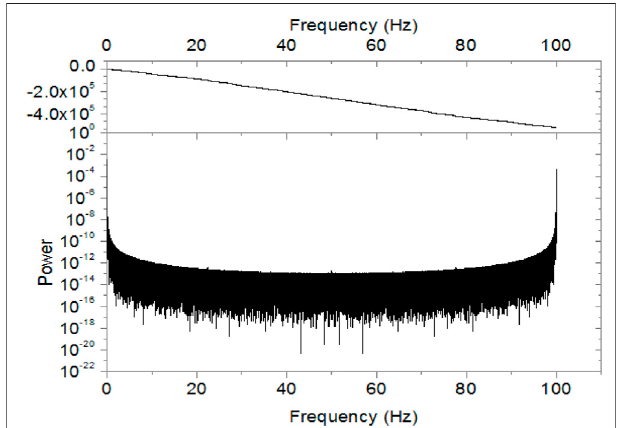
FIGURE 8 | Comparison of fl uctuating pressure values before and after fi ltering.